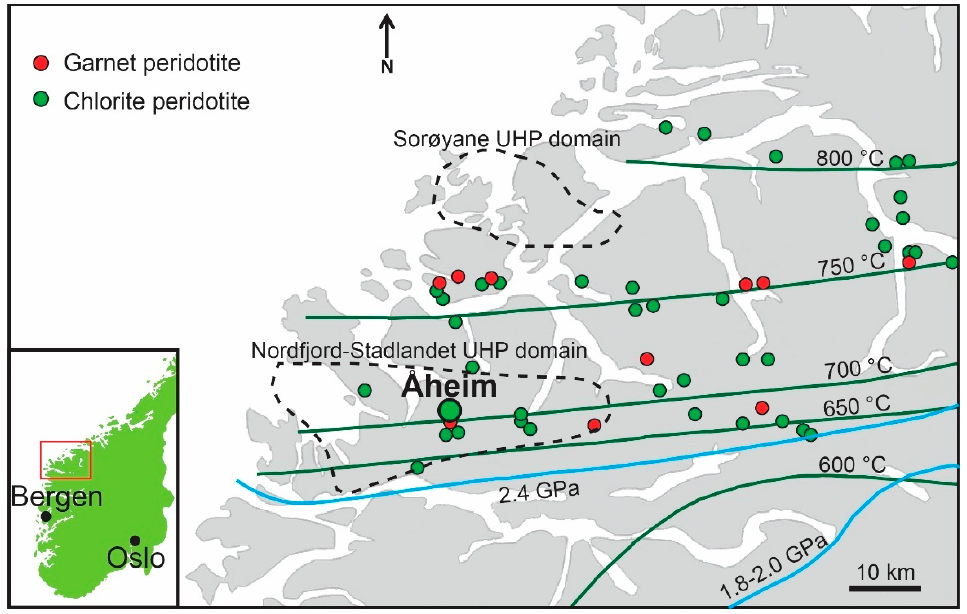
Figure 1. Distribution of peridotite bodies in the Western Gneiss Region, SW Norway (modified from Austrheim [42], Brueckner et al. [40], Jung et al. [41], Root et al. [50], and Wang et al. [52]). Magnified view of the red rectangle area, SW Norway. Samples selected for this study are from the Gusdal quarry in the Åheim region (larger green circle). Green lines indicate the approximate peak metamorphic temperature [56] , and light blue lines mark the eclogite isobar of 1.8–2.0 GPa and 2.4 GPa [44,52] . Locations of chlorite and garnet peridotite bodies are marked with green and red circles, respectively. Two ultra-high pressure (UHP) domains, Nordfjord–Stadlandet and Sorøyane, are contoured with black dashed lines.